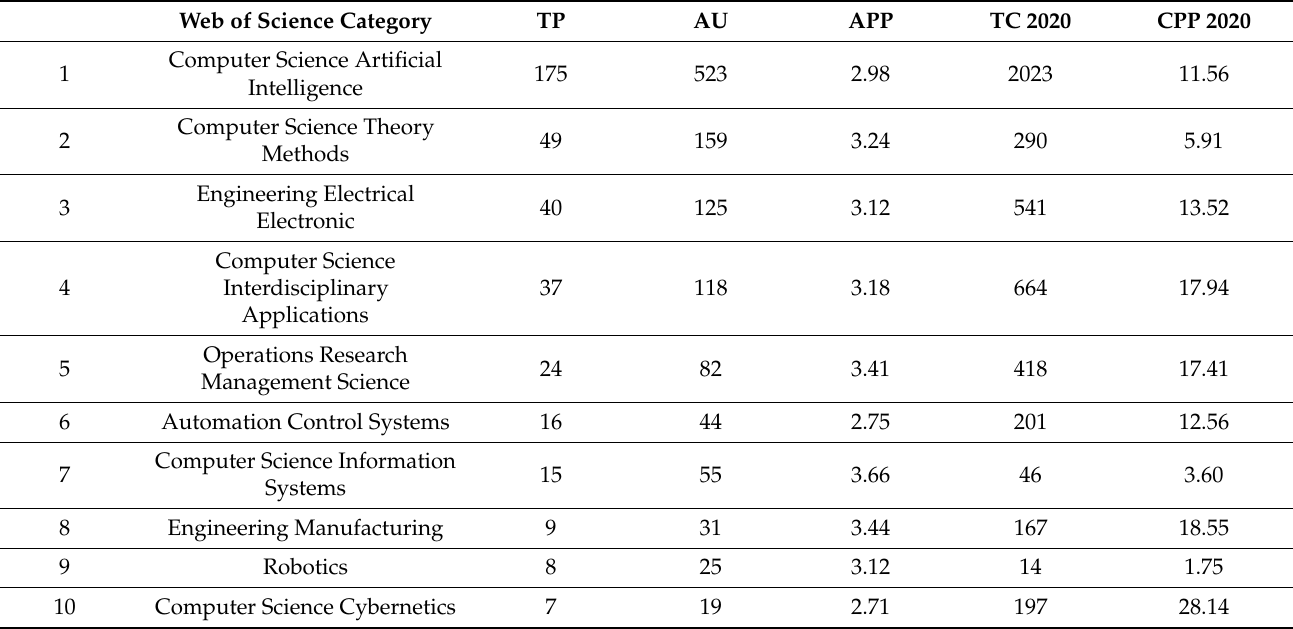
Figure 14. Density visualization bibliographic coupling (item density sources). Table 13. The top 10 productive WoS